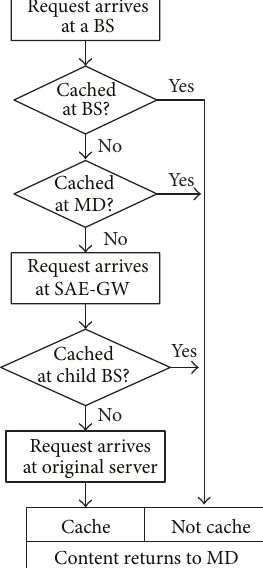
Figure 5: The operation procedure of coordinated edge caching